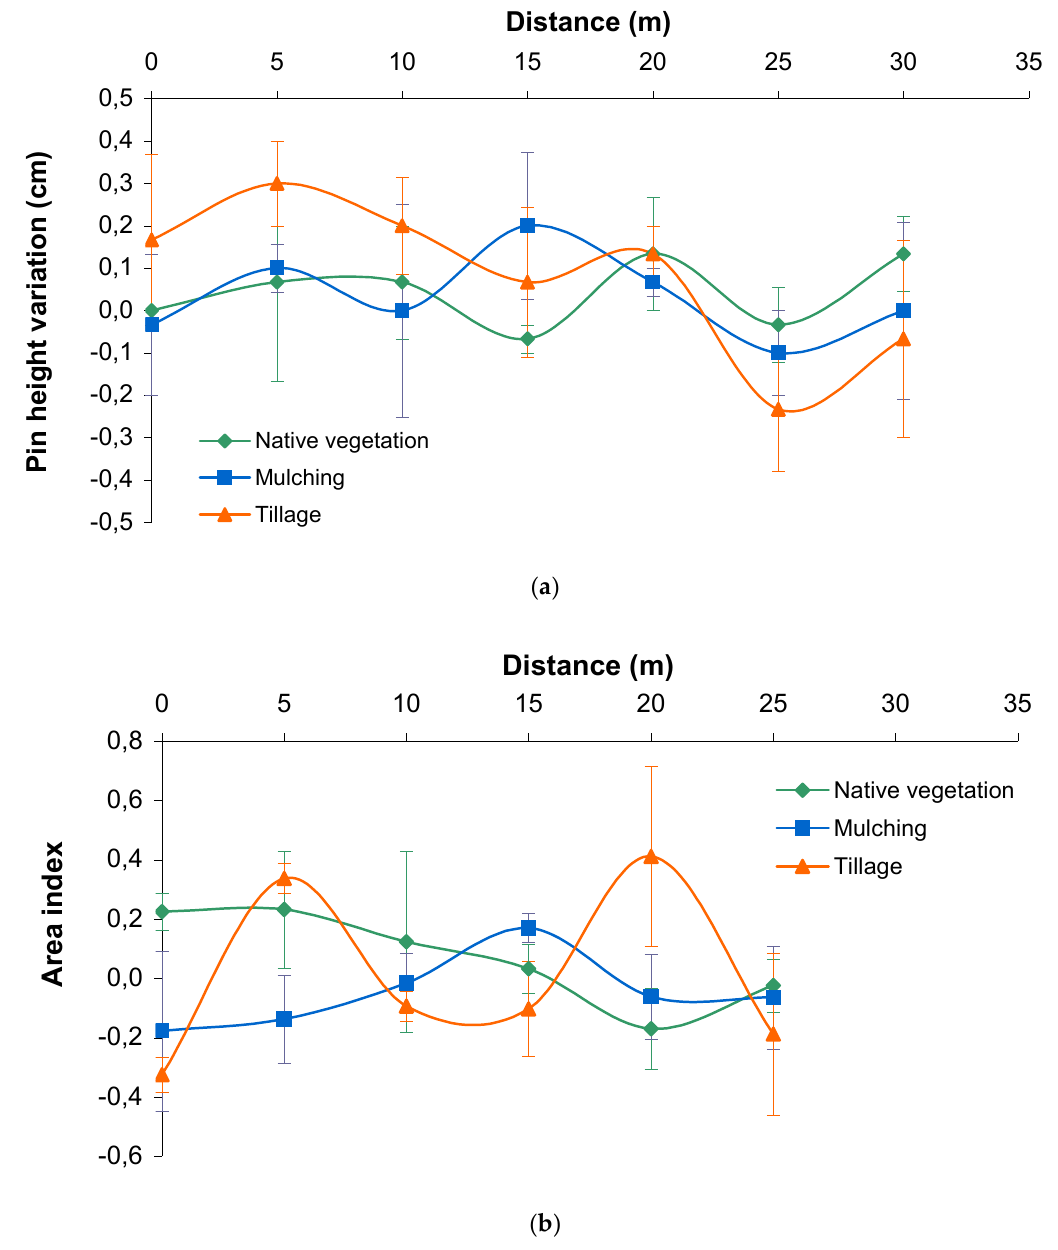
Figure 3. Pin height variation ( a ) and area index ( b ) over a year (May 2018 to April 2019) timespan for the treatments imposed in the Ribeira Sacra vineyard. Error bars refer to standard errors. Positive values of the area index indicate erosion, whereas negative values indicate soil deposition.